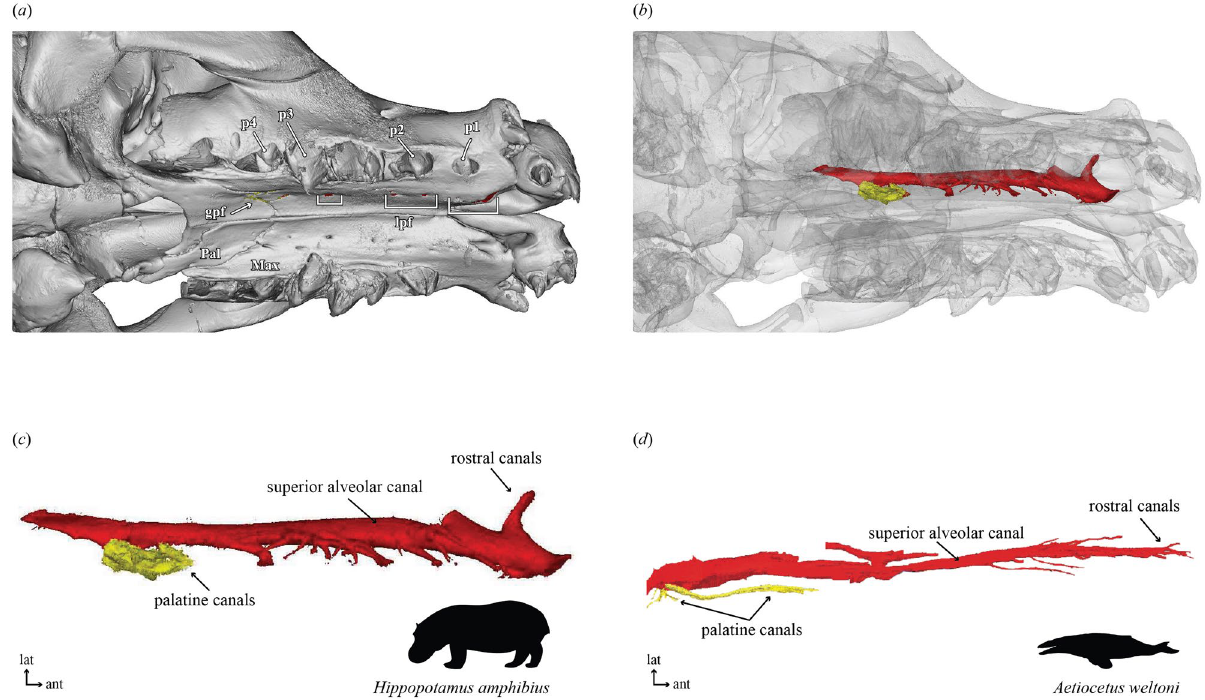
Figure 5. Palate of UMMZ 101782 ( Hippopotamus amphibius ) in oblique ventral view showing the skull ( a ) opaque and ( b ) transparent to illustrate the location and position of the internal canal system. Red illustrates the superior alveolar canal and its distributaries; yellow illustrates the greater palatine canal and its branches. Gpf greater palatine foramen, lpf lateral palatine foramina, Pal Palatine, Max Maxilla. ( c ) 3D reconstruction of the superior alveolar canal (red) and its distributaries, and the greater palatine canal (yellow) and its branches, in UMMZ 101782 ( Hippopotamus amphibius ). Models demonstrate that the palatal foramina are branches of the superior alveolar canal and are well anterior to the level at which the greater palatine canal exits the skull at the greater palatine artery. ( d ) Modified illustration of the same structures in UCMP 122900 ( Aetiocetus weltoni ) from 19 . 3D models show that the morphology observed in stem mysticetes by 19 is consistent in terrestrial